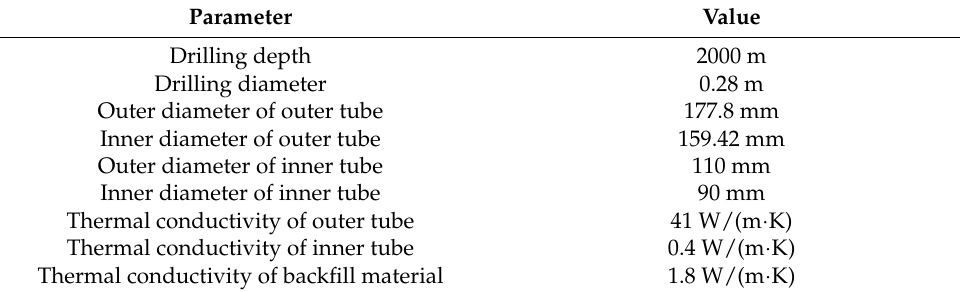
Table 1. Basic parameters of buried